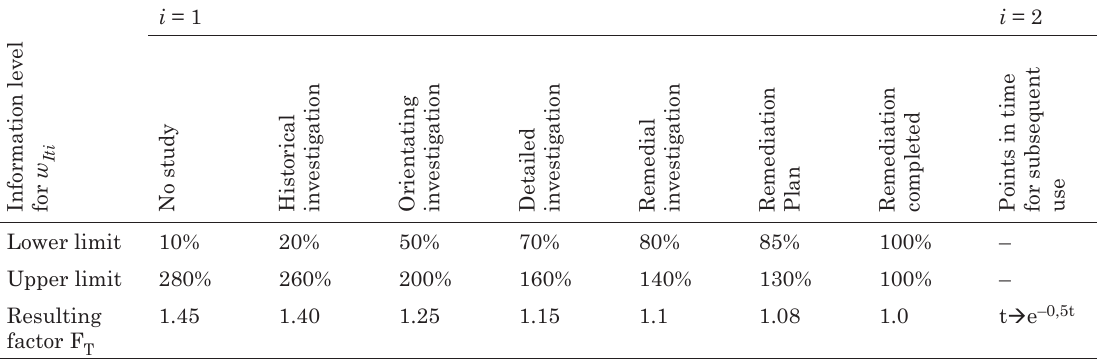
table 2. Informational risk